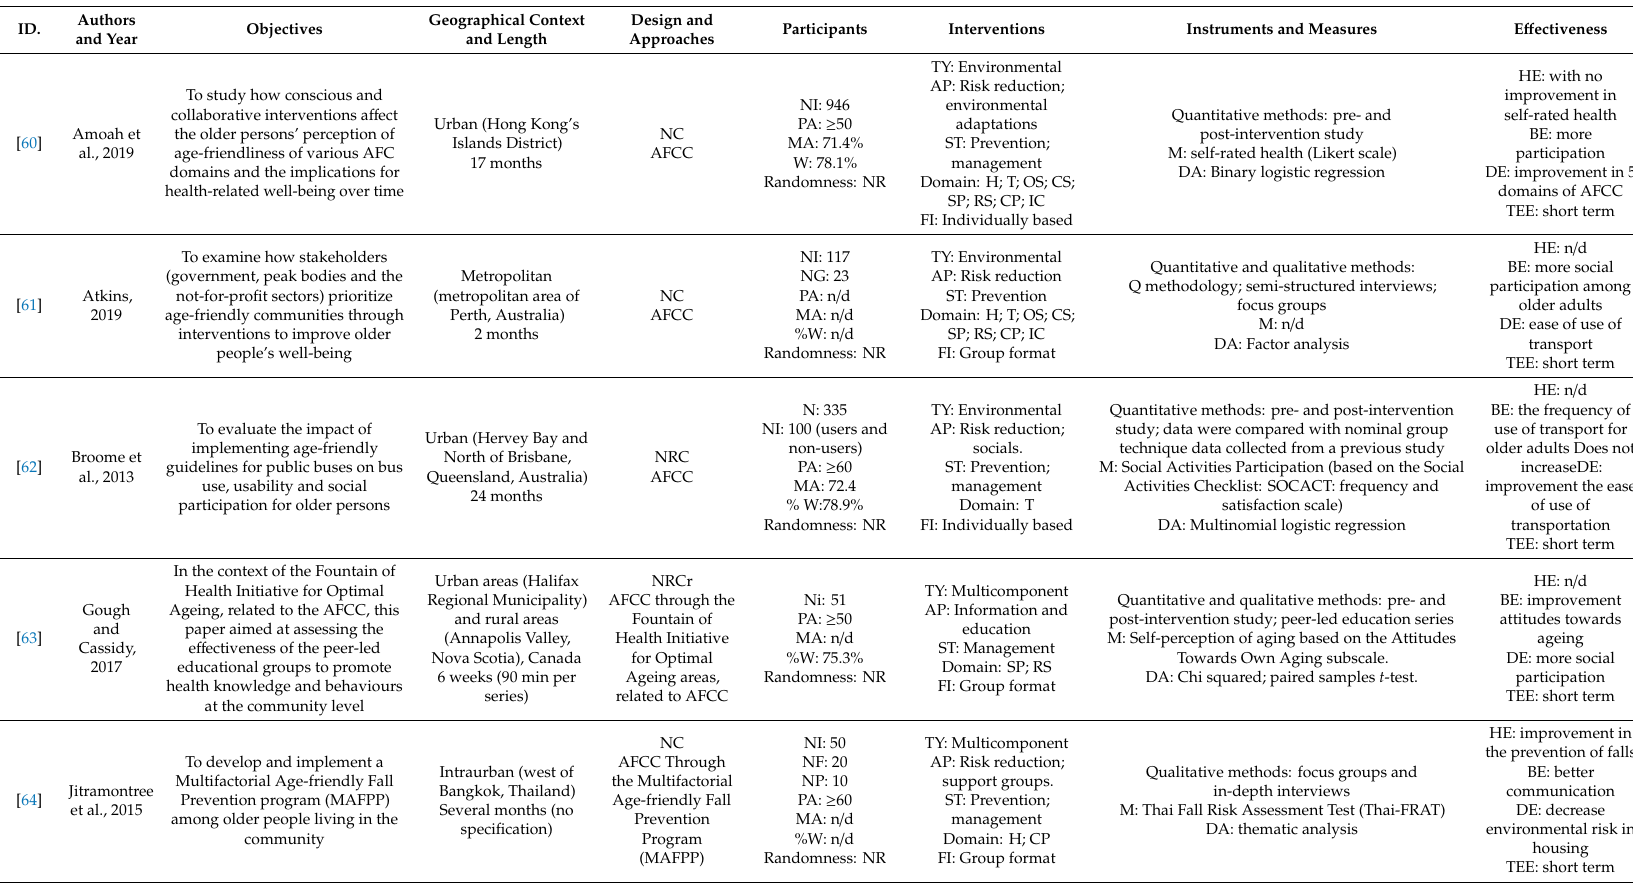
Table 2. Charting the data of included studies in the systematic